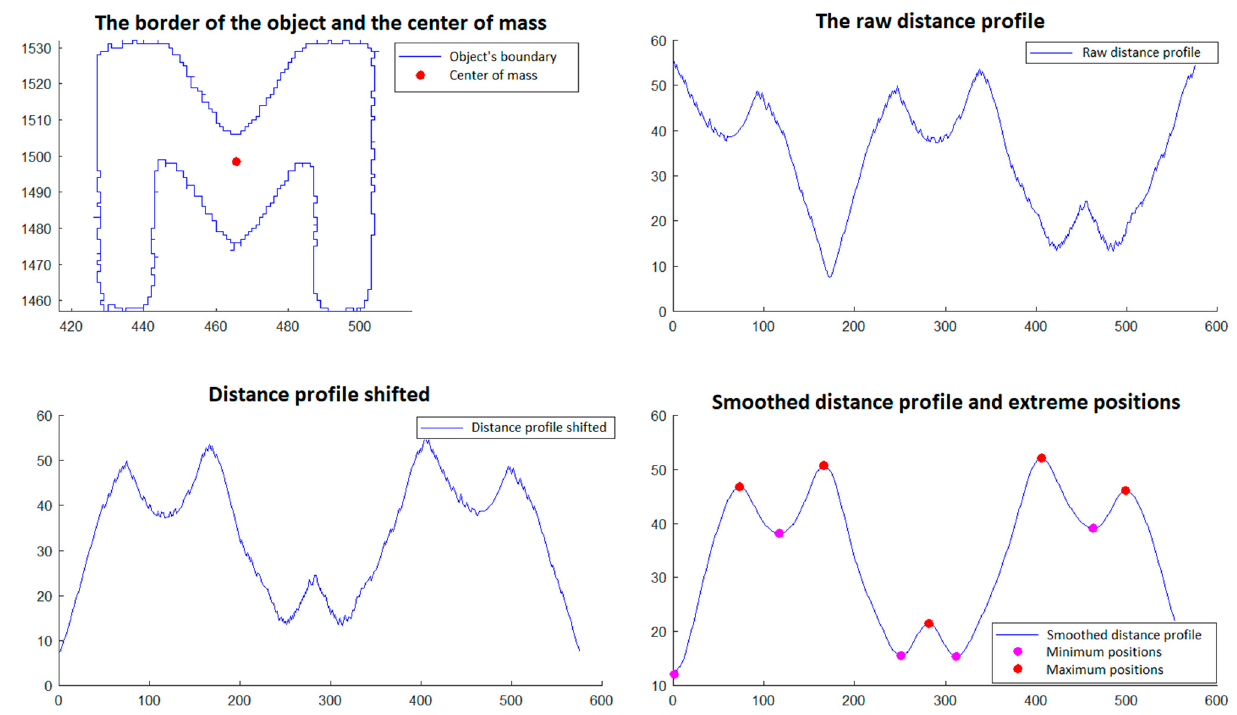
Figure 15. Triangular object selection procedure (step 5): non-triangular object.